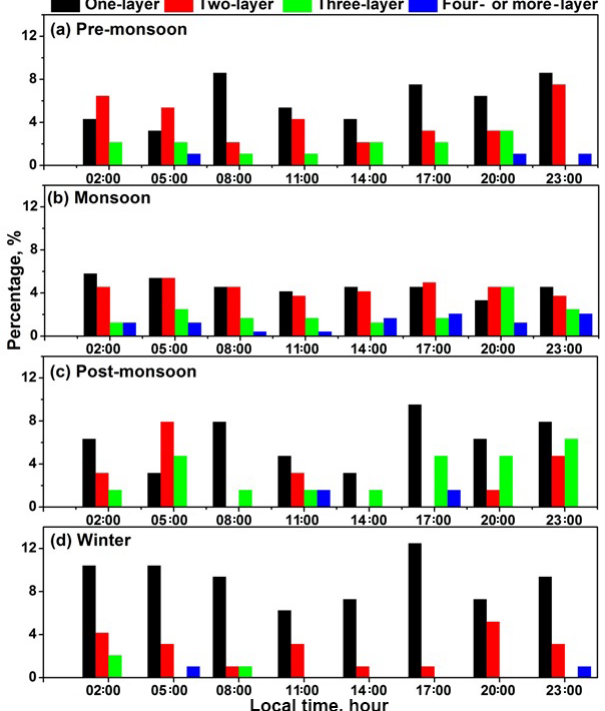
Figure 5. Diurnal variations of one-layer, two-layer, three-layer, and four- or more-layer clouds observed during (a) pre-monsoon, (b) monsoon, (c) post-monsoon, and (d) winter seasons.